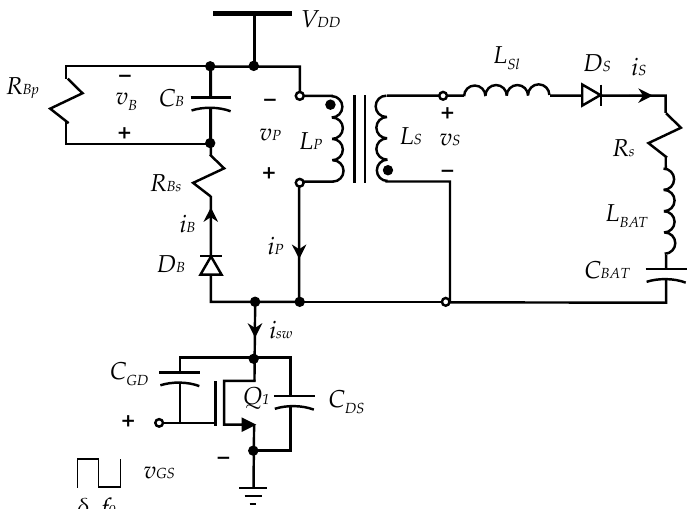
Figure 1. Flyback converter circuit.